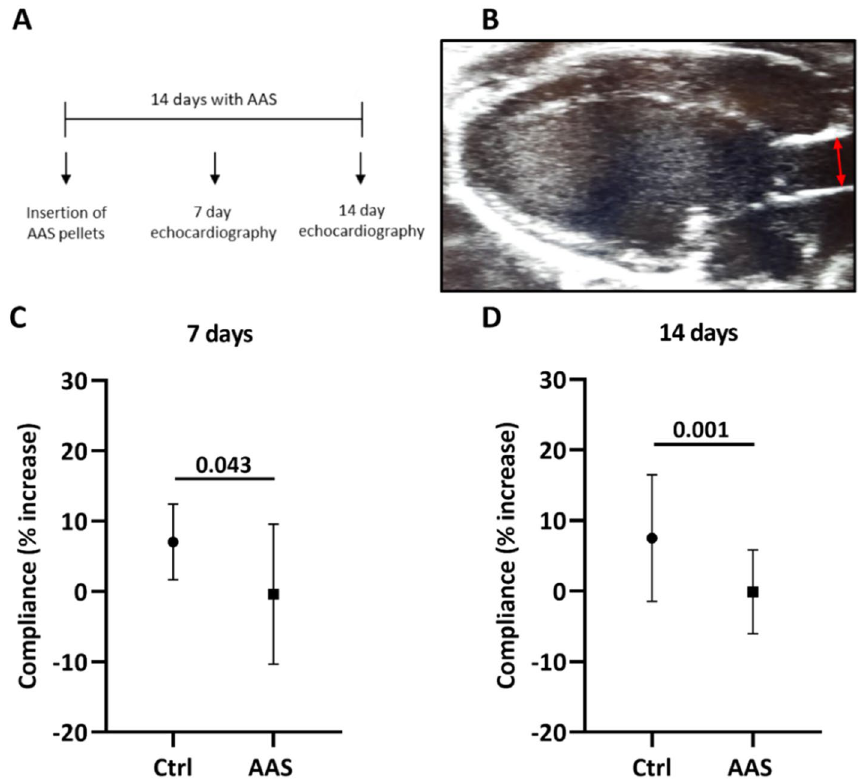
Figure 4. Method description and vascular function: ( A ) Timeline describing the series of experimental events in the animal study. Animals were exposed to testosterone (AAS) or sham pellets for 14 days. ( B ) B-mode image of a mouse heart acquired from 2D echocardiography showing the left ventricle in a parasternal long axis view, apex pointing to the left and aorta to the right. Double-headed arrow illustrates area of diastolic- and systolic diameter measurements of the ascending aorta. ( C , D ) Aortic compliance after 7 and 14 days of testosterone treatment, measured as percentage increase calculated from the difference in inner diameter (mm) of the ascending aorta within one heart cycle. Testosterone treated animals = AAS (N = 15), sham operated animals = Ctrl (N = 20). Data presented as mean ± SD.